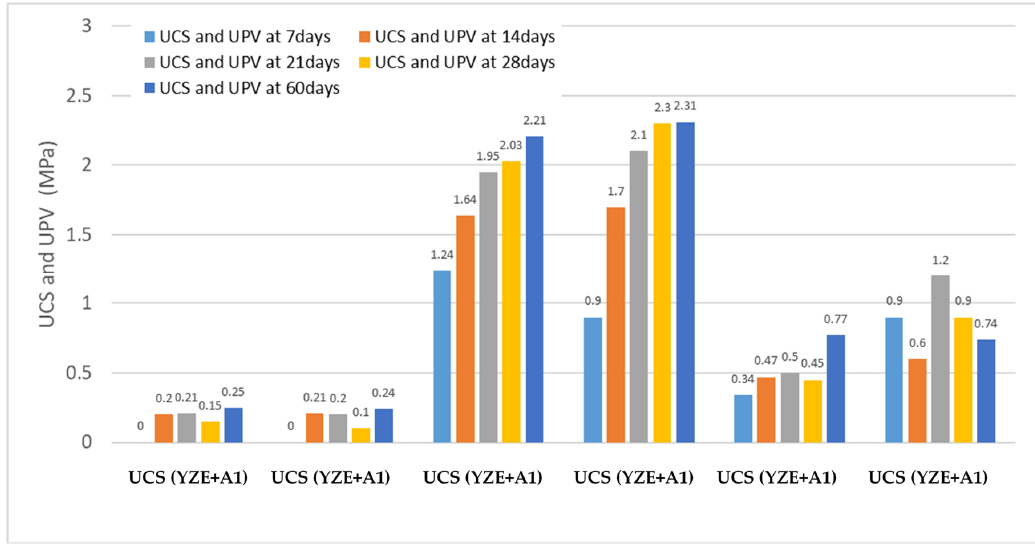
Figure 16. UCS and UPV values for YZE-N self-compacting mortars.